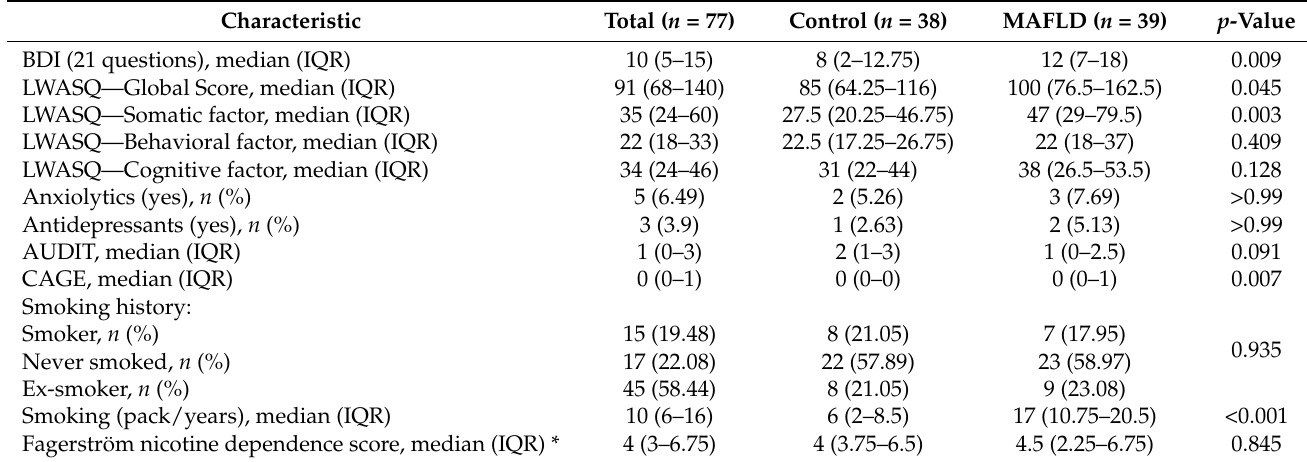
Table S1 outlines the obtained echocardiographic and Doppler ultrasound parameters.